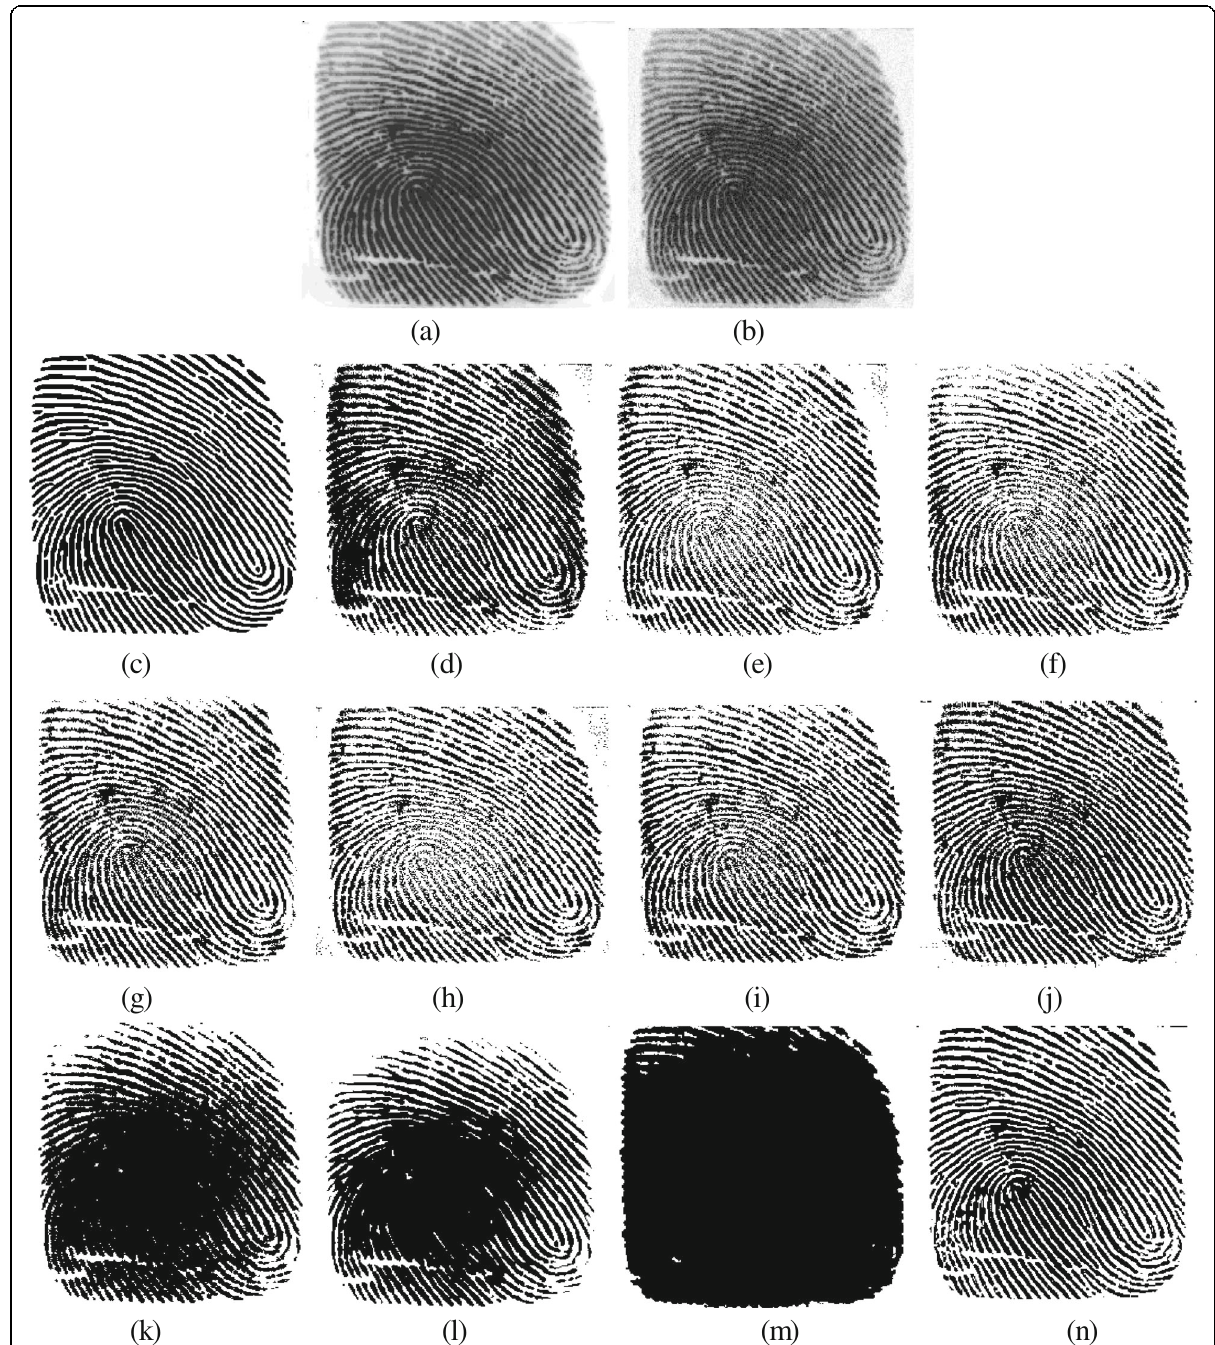
Fig. 10 Segmentation results on the fingerprint image 288 × 254 corrupted by the Gaussian noise (0, 0.002). a Original image. b Noisy image. c Ground-truth. d Bernsen ’ s method. e Niblack ’ s method. f Sauvola ’ s method. g Bradley ’ s method. h Chou ’ s method. i Valizadeh ’ s method. j Wei ’